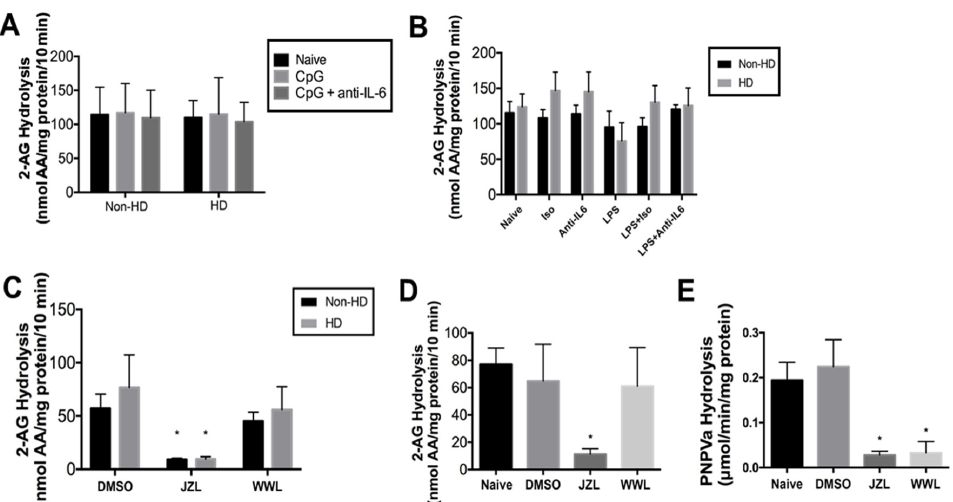
Figure 2. 2-arachidonoylglycerol (2-AG) hydrolytic activity and carboxylesterase (CES) activity